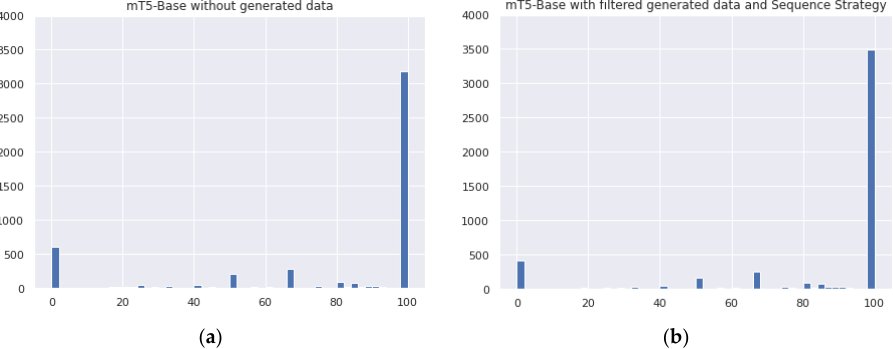
Figure 10. F1 distribution of the Thai Wiki QA dataset: ( a ) the result from the mT5-Base baseline model, and ( b ) the result from the combination mT5-SEQ-FLT of the Thai Wiki QA dataset.